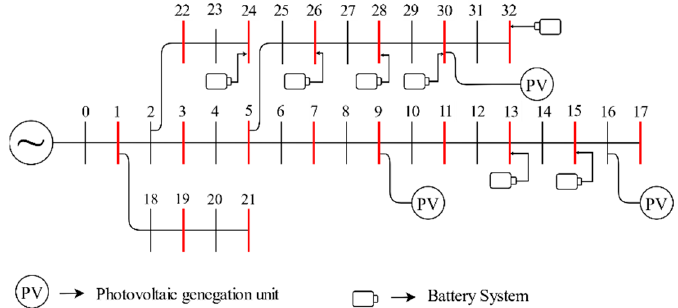
Figure 5. Battery allocation obtained by solving the optimization problem using the NPV.